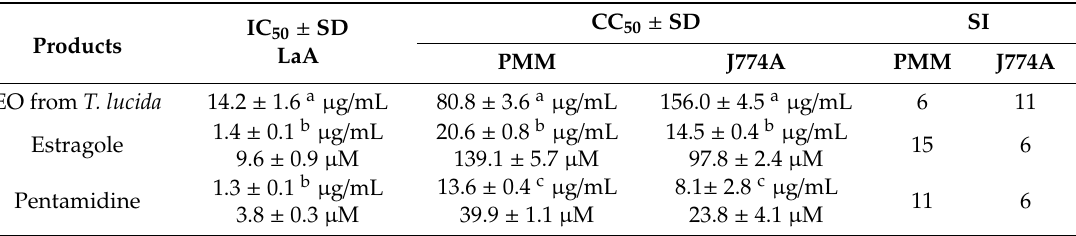
Table 1. Antileishmanial activity against intracellular amastigotes of Leishmania amazonensis , cytotoxic e ff ects on macrophages, and selectivity of the essential oil from Tagetes lucida Cav., estragole, and